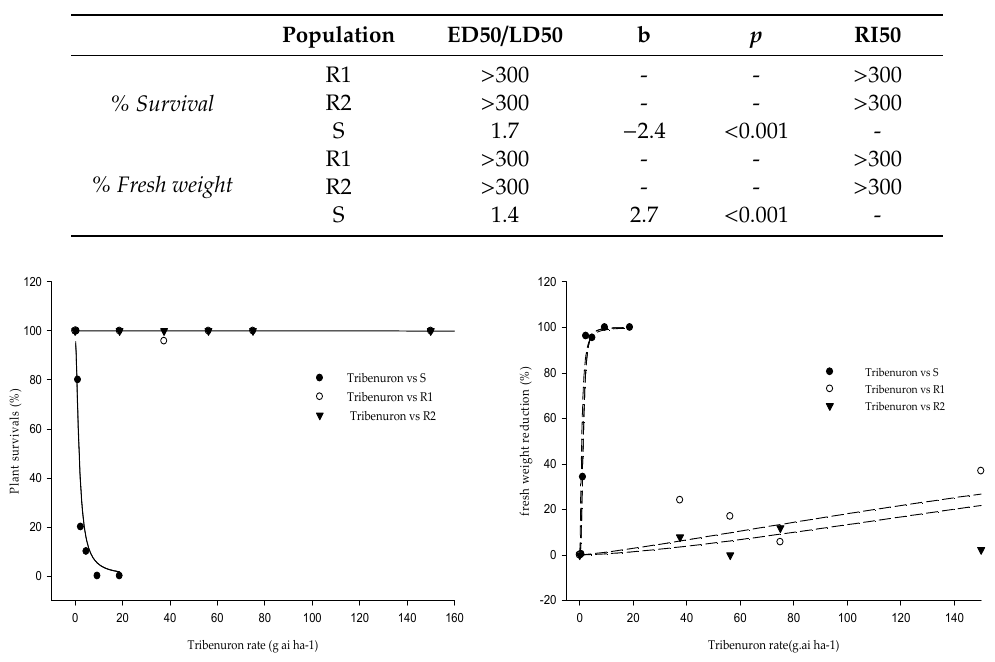
Table 5. Parameters of the log-logistic equations used to calculate the tribenuron-methyl rates required for 50% reductions in fresh weight (ED50) and percent survival (LD50) expressed as the percentage of the mean untreated control of the G. coronaria populations.